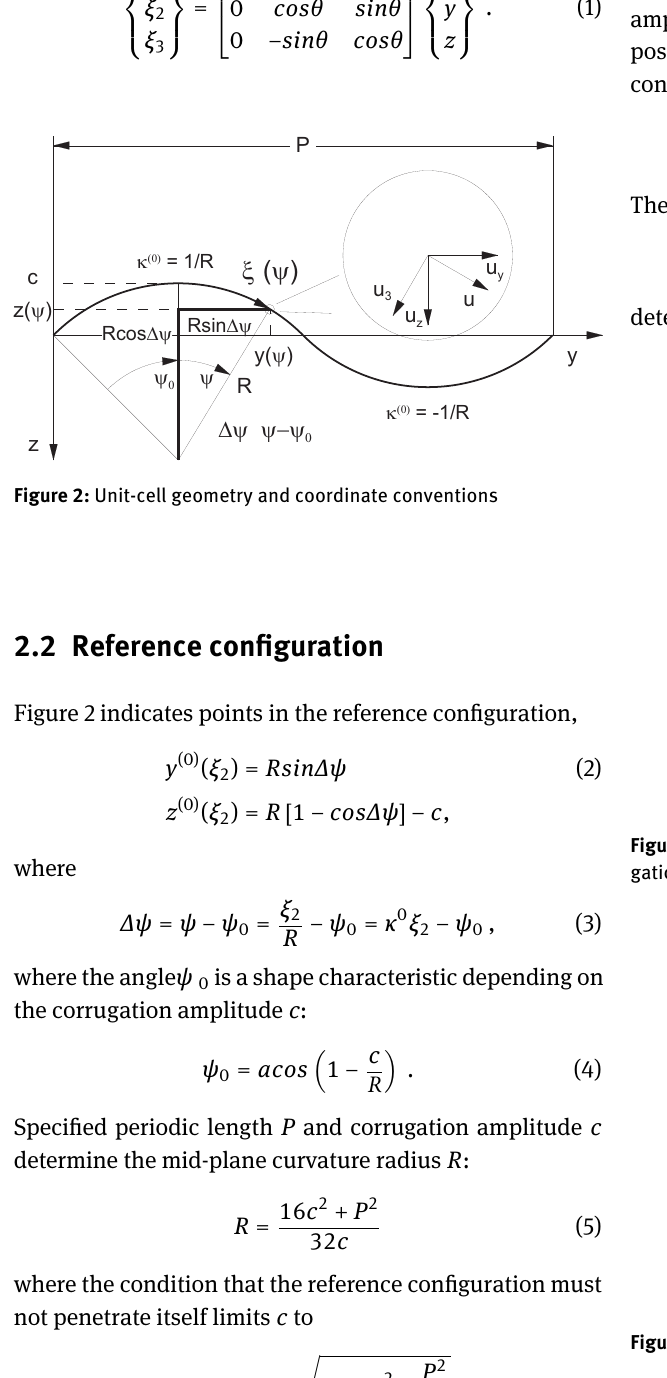
Figure 4: Morphing-stretch